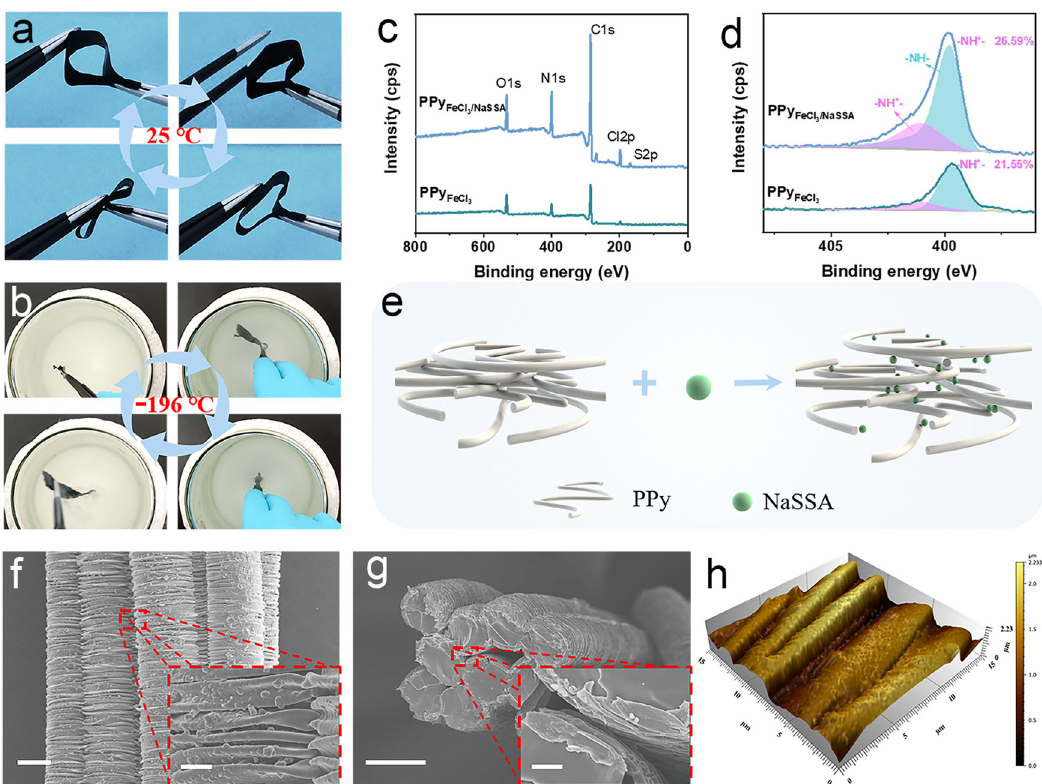
Fig. 2 Characterization of the ultrastretchable PU@PPy multi fi lament. a PPy fi lms bending at room temperature. b PPy fi lms waving in liquid nitrogen. c Full scan XPS spectra; High resolution spectra of d N1s of PPy fi lms. e Schematic illustration of stretchable PPy with NaSSA as @PPy without PDA treatment from f longitudinal and g cross-section views. Scale bar is: 50 μ m, inset plasticizer. SEM images of the PU 210D 300 % 5 μ m. h AFM image of the PU 210D @PPy with PDA 300 %